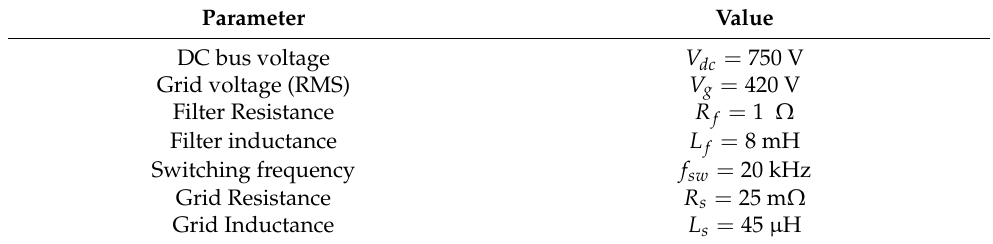
Table 1. System Parameters.